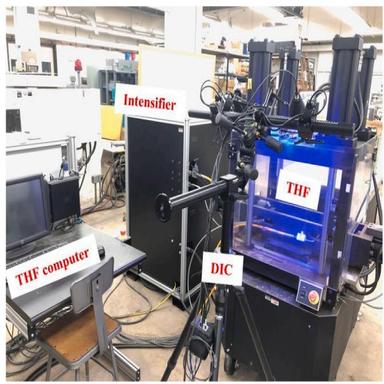
Experimental tube bulging and DIC setup.